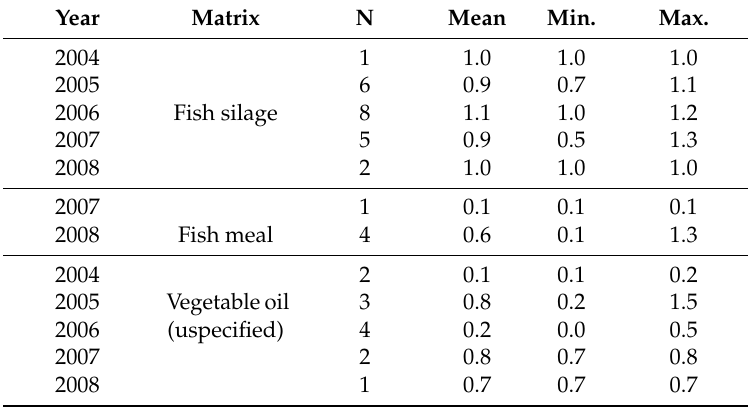
Table 1. Erucic acid (22:1n-9) as percentage of total fatty acids in fish feed and feed ingredients. The table shows the number of samples (N) for each year and matrix, the mean value of erucic